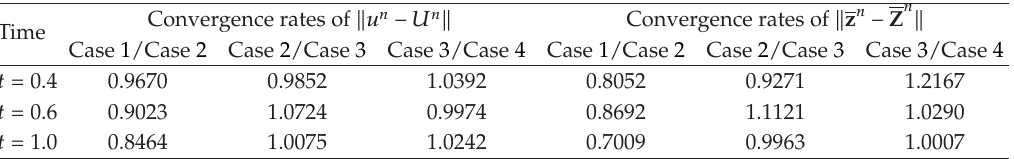
Table 3: Convergence rate of L 2